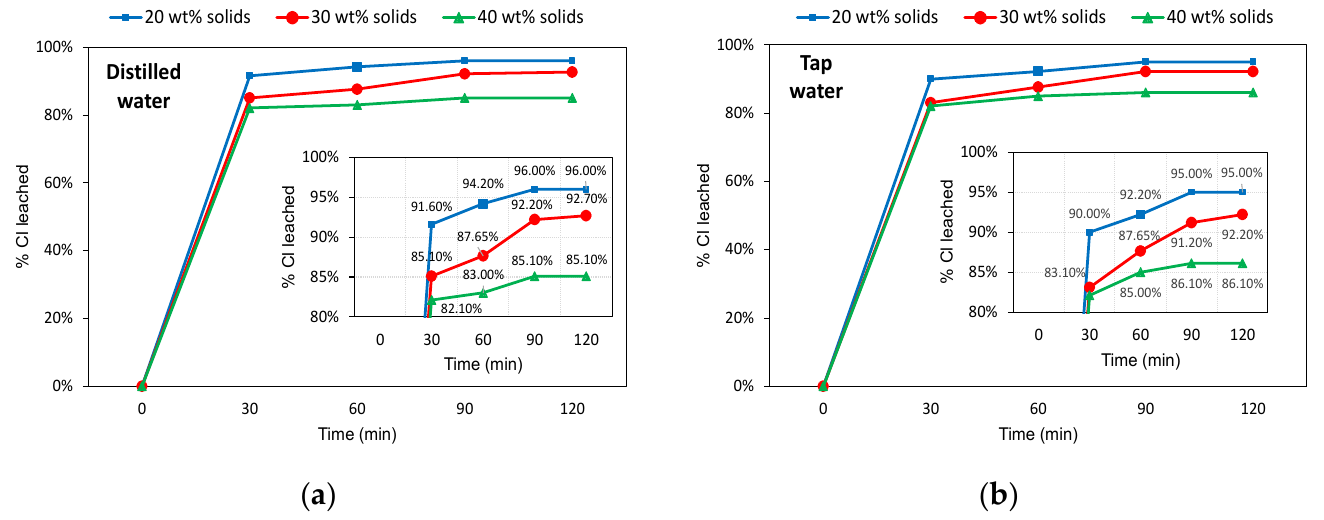
Figure 5. Leaching e ffi ciencies (% Cl removed) over time for the − 2.8 mm slag samples. ( a ) Distilled water system; ( b ) Tap water system.